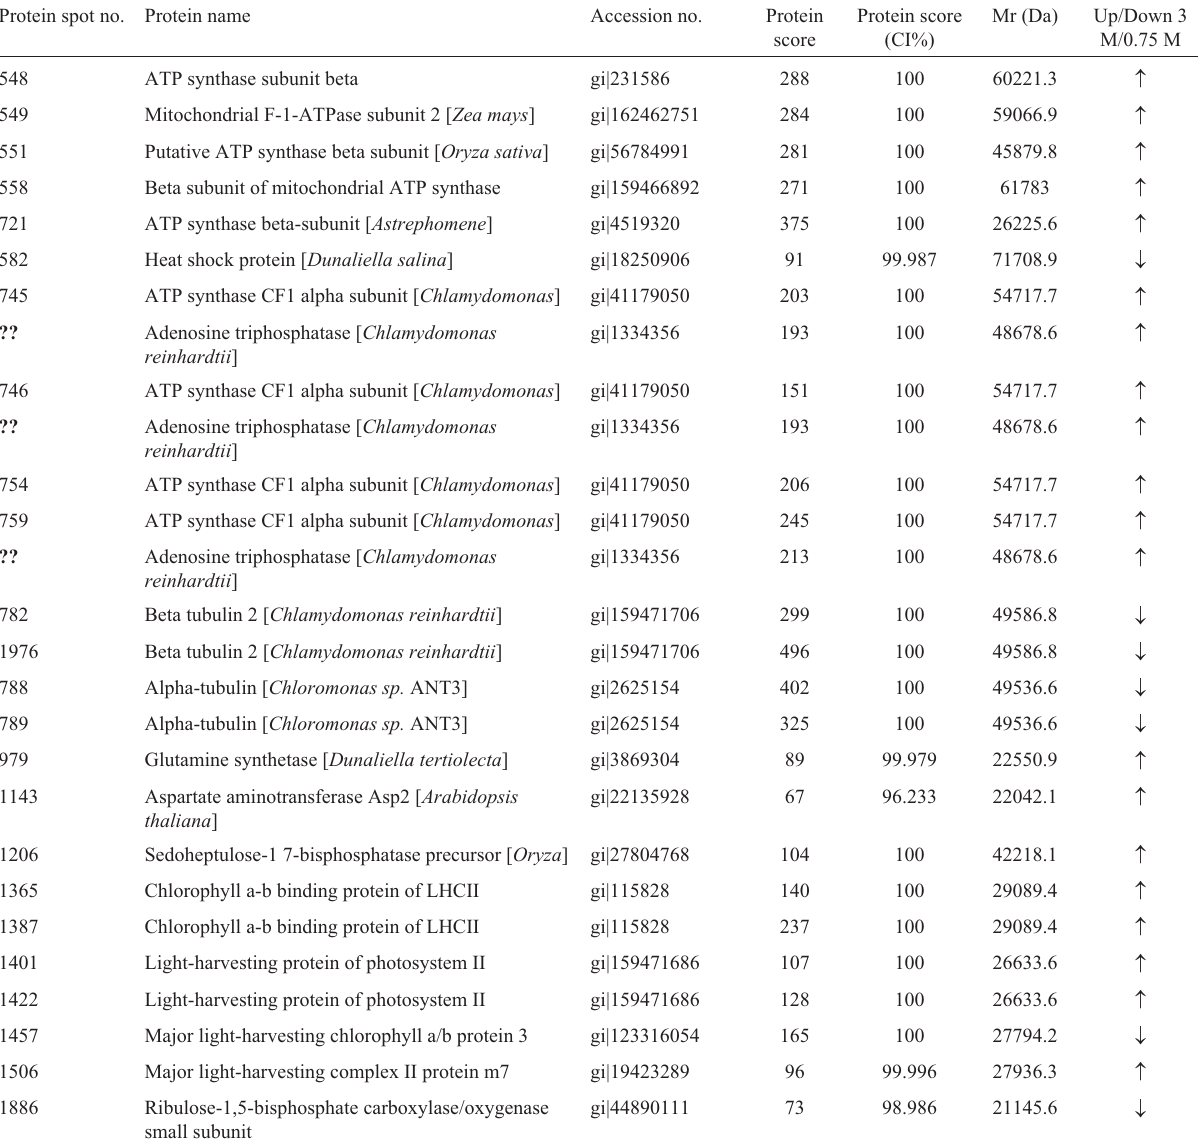
Table 2 - Summary of 24 differentially expressed protein spots identified by MALDI-TOF/TOF MS after DIGE analysis. Protein spot no. Protein